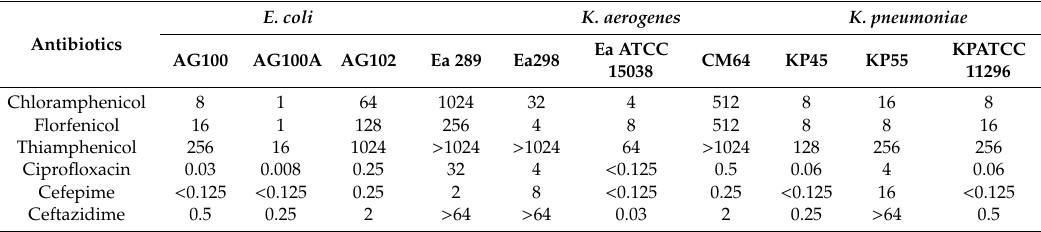
Table 2. Minimal inhibitory concentrations (MICs, mg / L) of the di ff erent antibiotics against the tested bacterial species MIC.